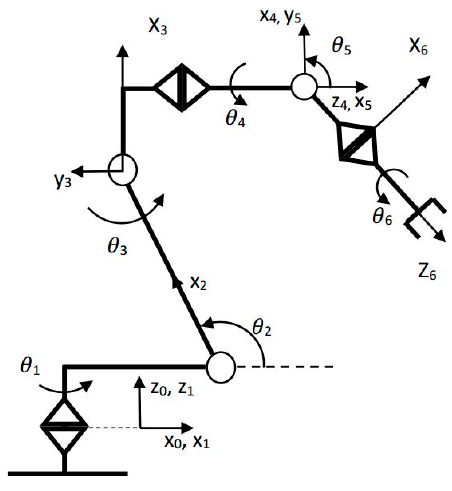
Figure 1. Sketch of a serial robot (YS100). Table 1. Nominal D–H constraints of the YS100 robot.